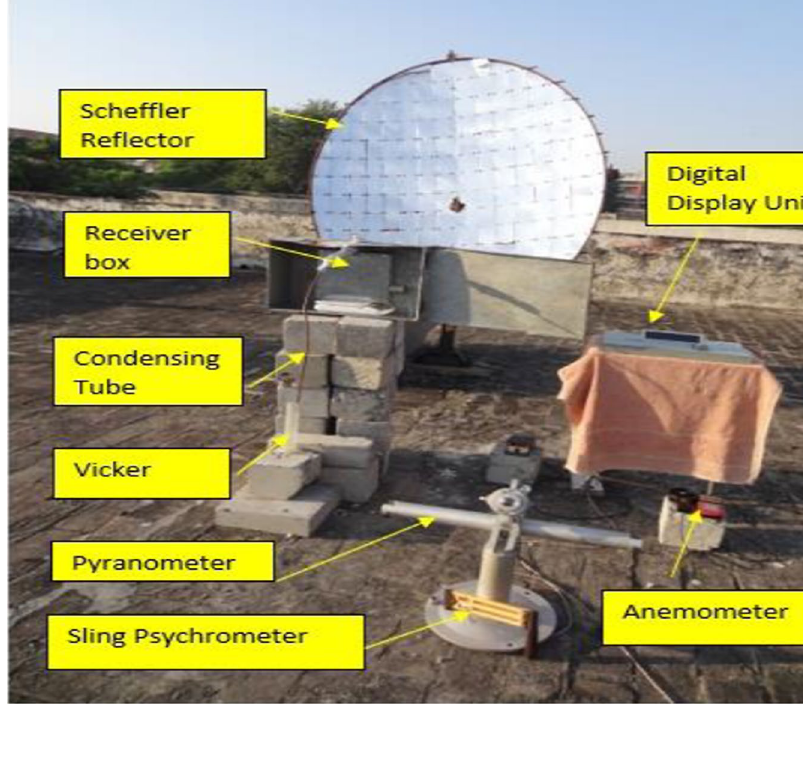
Fig. 3 Variation of water production with solar intensity w.r.t. time for activated alumina